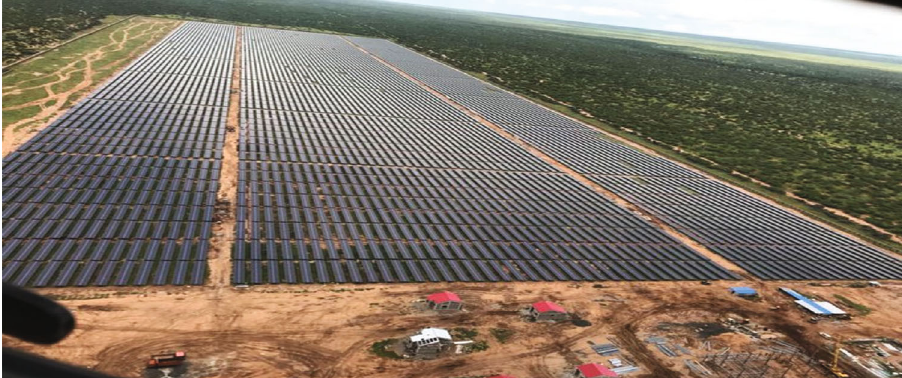
Figure 15: Mbalambala Garissa solar PV minigrid with 200,200 solar panels and 50.0MW capacity (photo on-site at Mbalambala Garissa). Table 6: Description of institutions involved in Kenya ’ s energy sector.